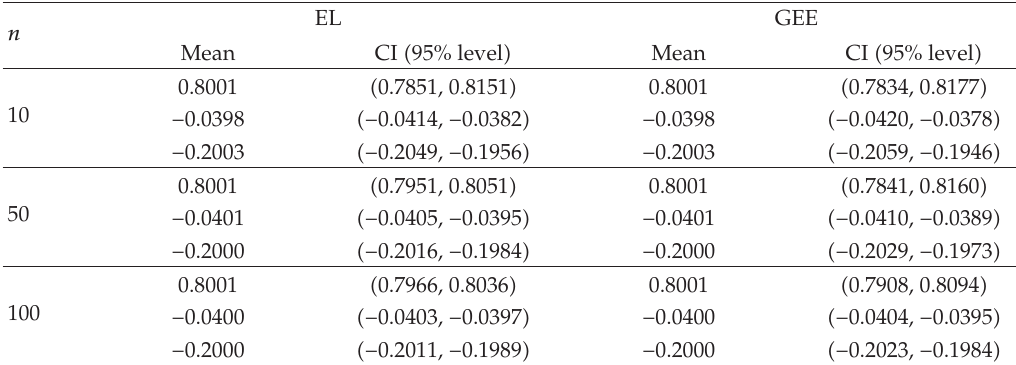
Table 1: Means of parameter estimates for β with its standard derivation (cid:3) SD (cid:4) and mean length (cid:3) ML (cid:4) of the confidence region, when the estimation method are empirical likelihood (cid:3) EL (cid:4) and general estimation equation (cid:3) GEE (cid:4) ,